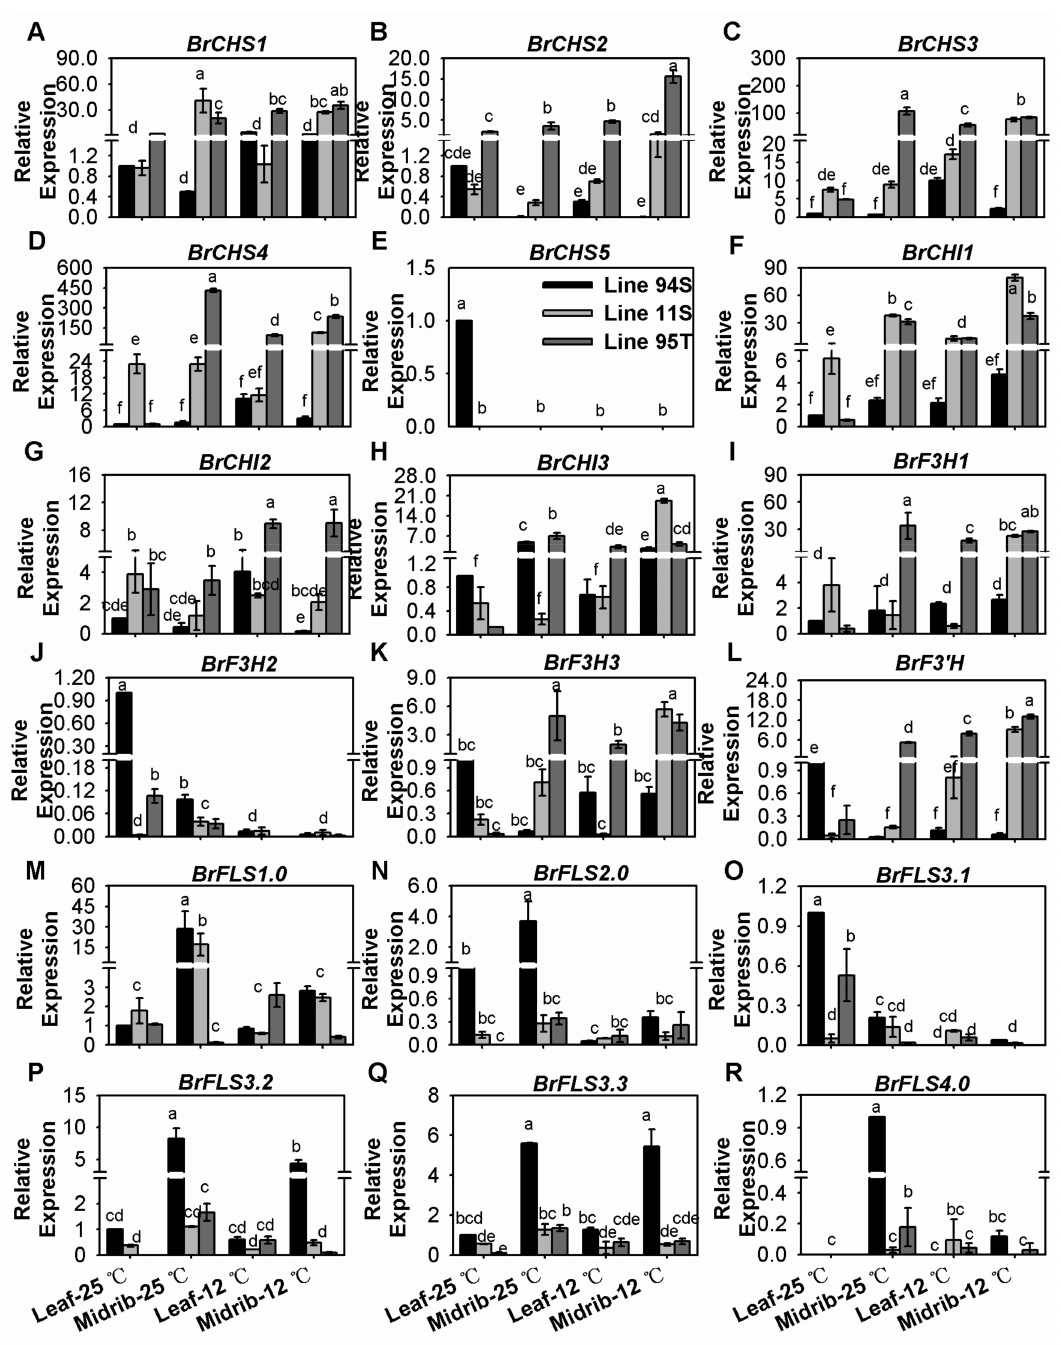
Figure 3. Expression of early biosynthesis genes (EBGs) in the seedlings of three Chinese cabbages under low temperature treatment. ( A – E ) relative expression of BrCHSs ; ( F – H ) relative expression of BrCHIs ; ( I – K ) relative expression of BrF3Hs ; ( L ) relative expression of BrF3’H ; ( M – R ) relative expression of BrFLSs . Plants of three lines were grown under a 12-h light photoperiod at 25 ◦ C, 125 mmol m − 2 s − 1 ; 28-days seedling were treated at 12 ◦ C for 15 days, and the seedlings that stayed at 25 ◦ C with same light condition were treated as the control. Seedling leaves were divided into the midribs and the leaves, and leaves of Line94S at 25 ◦ C served as the control. Values are presented as means ± SD ( n = 3). The di ff erent letters above each column are significantly di ff erent at p < 0.05 by Duncan’s